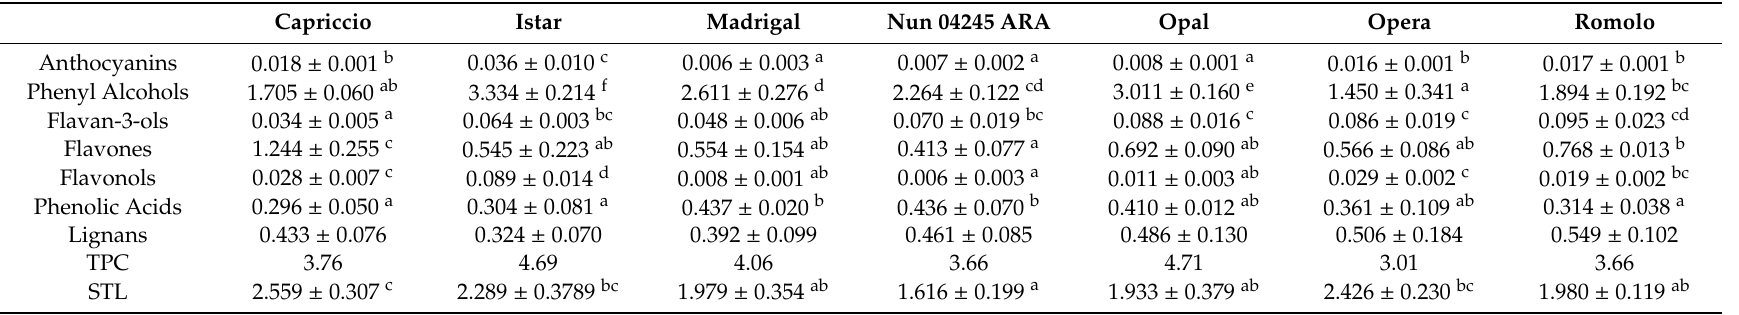
Table 2. Semi-quantitative analysis of the main phenolic classes and sesquiterpene lactones (STL) characterizing the di ff erent artichoke cultivars. TPC: total